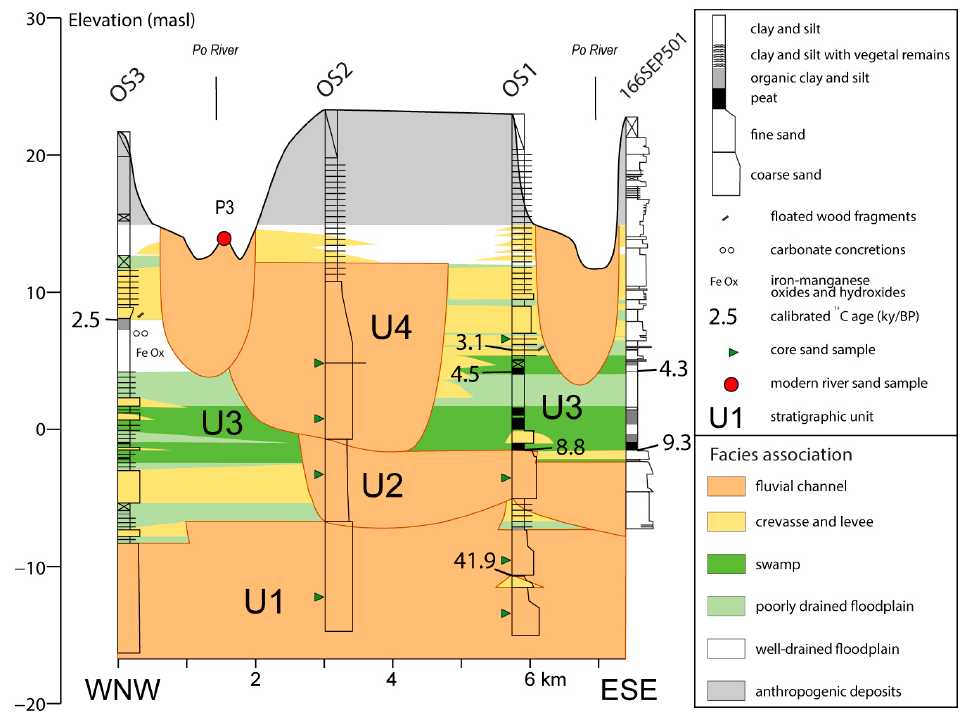
Figure 4. Stratigraphy of the Ostiglia area. Correlation panel showing facies distribution in the subsurface of the study area down to 38 m depth (location in Figure 2b). Details on radiocarbon dates from cores OS1 and OS3 are in Table 1. Stratigraphy and radiocarbon dates from core 166SEP501 are from [26].